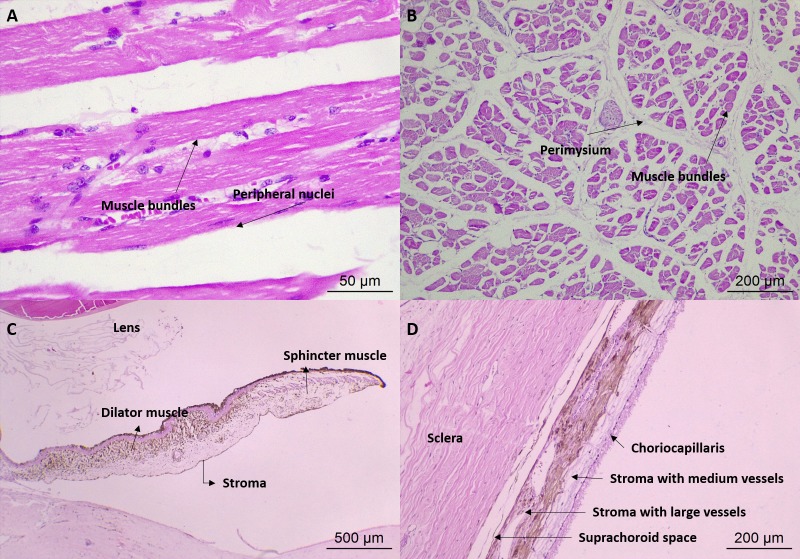
Photomicrography of the eye and adnexa of crab-eating fox.(A) Longitudinal section of an extraocular muscle: bundles of cylindrical fibers, elongated, multinucleated, with peripheral nucleus; HE, 20X magnification. (B) Transverse section of the extraocular muscle; HE, 10X magnification. (C) Iris: connective tissue stroma, the sphincter and dilator muscle; HE, 5X magnification. (D) Choroid: suprachoroid space, stroma with large vessels, stroma with medium vessels, and choriocapillaris; HE, 10X magnification.